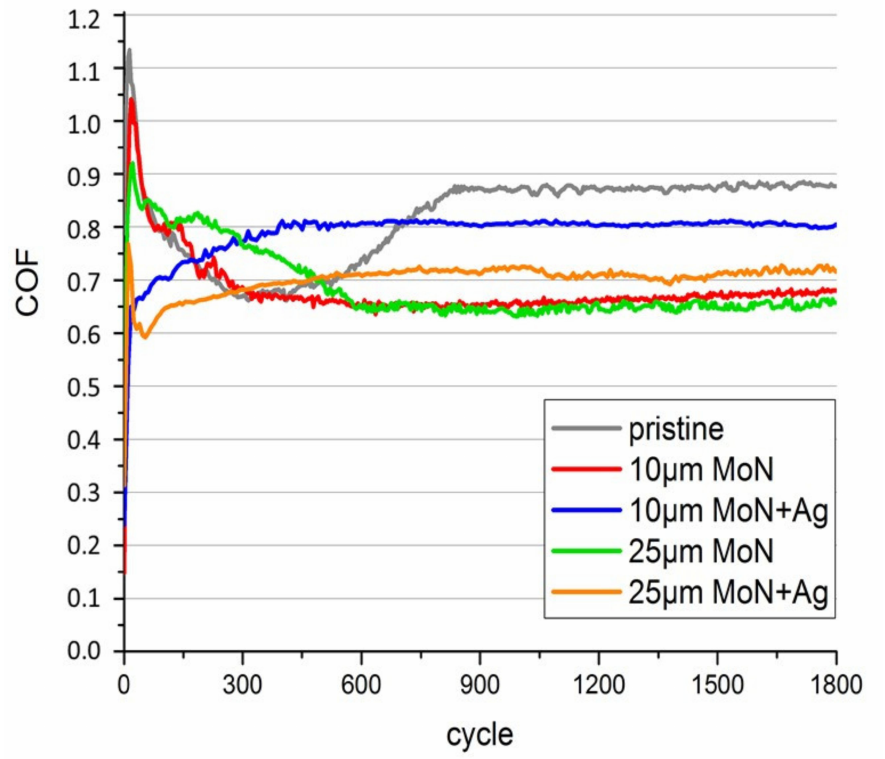
Figure 2. COF extracted from oscillation tribometry over a period of t = 15 min. The grey curve provides data of the reference surface. Red and green refer to the MoN surfaces on embossed substrates; blue and orange contain silver-filled